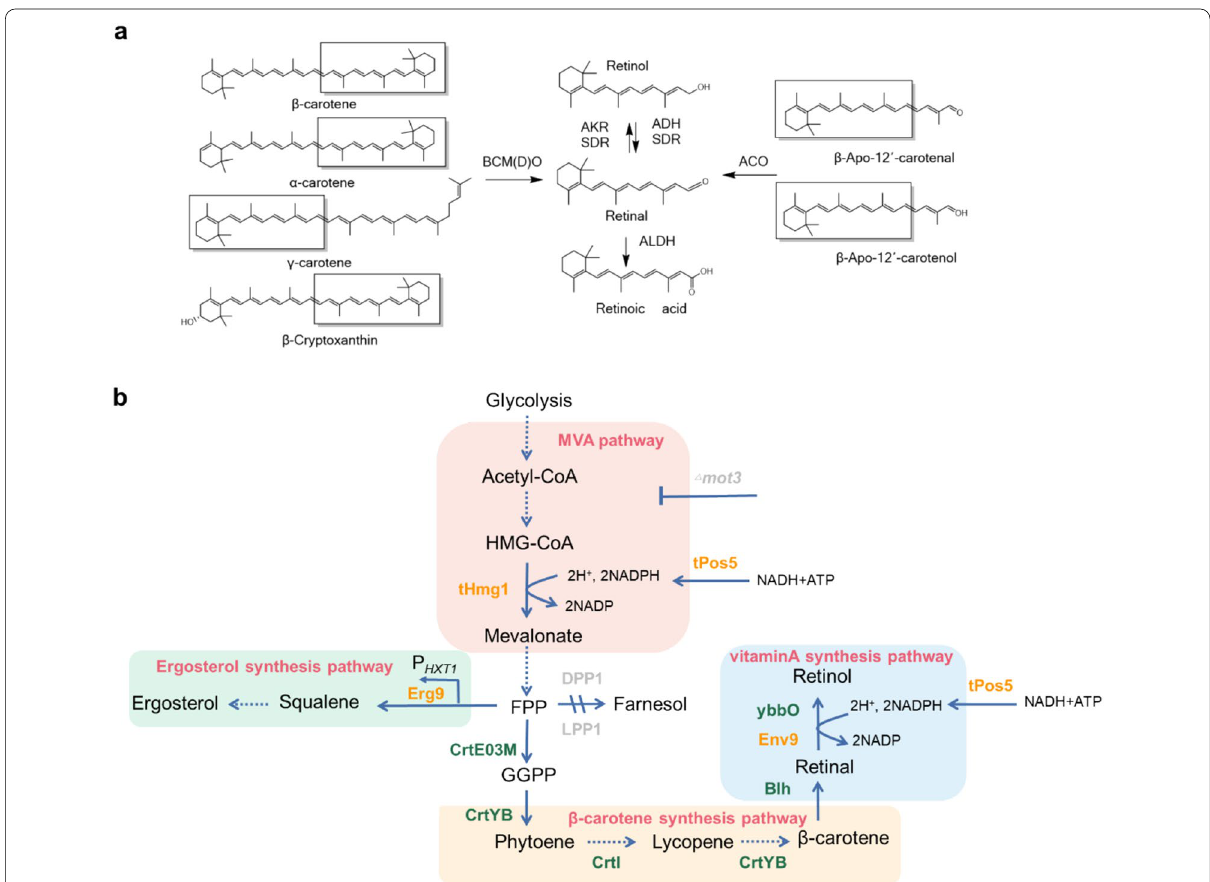
Fig. 1 Vitamin A biosynthesis. a Biosynthesis of retinal and its conversion to other retinoids. BCDO, β-carotene 15,15 ʹ -dioxygenase; BCMO, β-carotene 15,15 ′ -monooxygenase; ACO, apo-carotenoid 15,15 ′ -oxygenase; ALDH, aldehyde dehydrogenase; SDR, short-chain dehydrogenase/ reductase; AKR, aldo-keto reductase; ADH, alcohol dehydrogenase. b Vitamin A biosynthetic pathway in S. cerevisiae . The biosynthetic pathway starts from the endogenous mevalonic acid (MVA) pathway, extended by a β-carotene synthetic pathway module consisting of CrtE03M , CrtYB and CrtI from Xanthophyllomyces dendrorhous and the vitamin A formation module containing the Halobacterium sp. β-carotene dioxygenase gene BLH and the retinal reductase genes ( ybbO from E. coli and ENV9 from S. cerevisiae ). The major competing branches for the key precursor farnesyl pyrophosphate (FPP) include the ergosterol synthetic pathway and the phosphatase-catalyzed formation of farnesol. Diacylglycerol pyrophosphate phosphatase gene DPP1 and lipid phosphate phosphatase gene LPP1 were knocked out and used as integration sites. The exogenous enzymes introduced are shown in green, the endogenous enzymes are depicted in orange and those deleted are depicted in gray. HMG-CoA, 3-hydroxy -3-methyl-glutaryl-CoA; FPP, farnesyl pyrophosphate; GGPP, geranylgeranyl diphosphate; tHmg1, truncated 3-hydroxy-3-methyl-glutaryl reductase; CrtE, geranylgeranyl diphosphate synthase; CrtI, phytoene desaturase; CrtYB, phytoene synthase/ lycopene cyclase; Blh, bacterirhodopsin-related-pr otein-like homolog protein (later identified as β-carotene dioxygenase); ybbO, aldehyde reductase; tPos5, truncated NADH